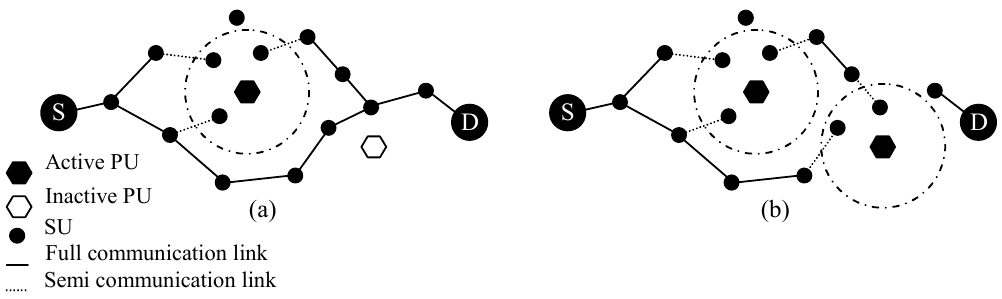
Figure 3. Network model and communication links in